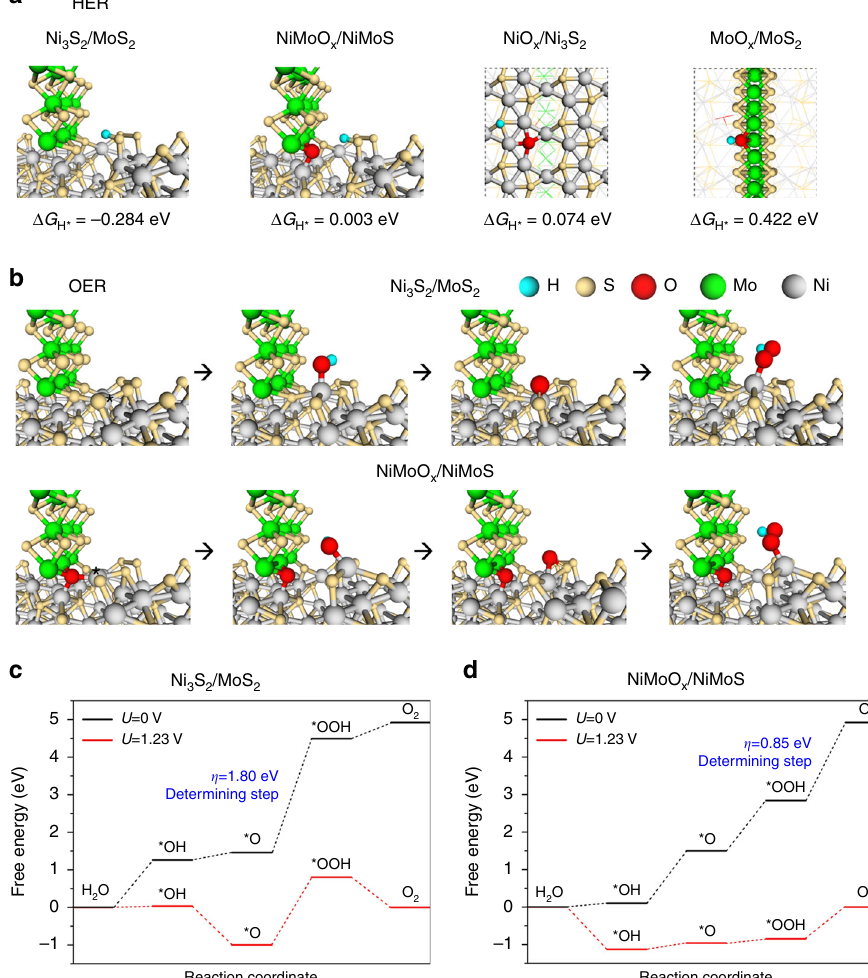
Fig. 8 Origin of HER/OER activities on NiMoO x /NiMoS. a Chemisorption models and corresponding Gibbs free energy of H on the interface of Ni 3 S 2 / MoS 2 and NiMoO x /NiMoS, on the surface of NiO x /Ni 3 S 2 (S) and on the edge of MoO x /MoS 2 (Mo). b OH, O, and OOH intermediates adsorption con fi gurations for OER on the interface of (top) Ni 3 S 2 /MoS 2 and (bottom) NiMoO x /NiMoS. c , d The free energy diagrams for OER on the interface of c Ni 3 S 2 /MoS 2 and ( d ) NiMoO x /NiMoS heterostructures. Cyan, yellow, red, green, and gray balls, respectively, represents H, S, O, Mo, and Ni